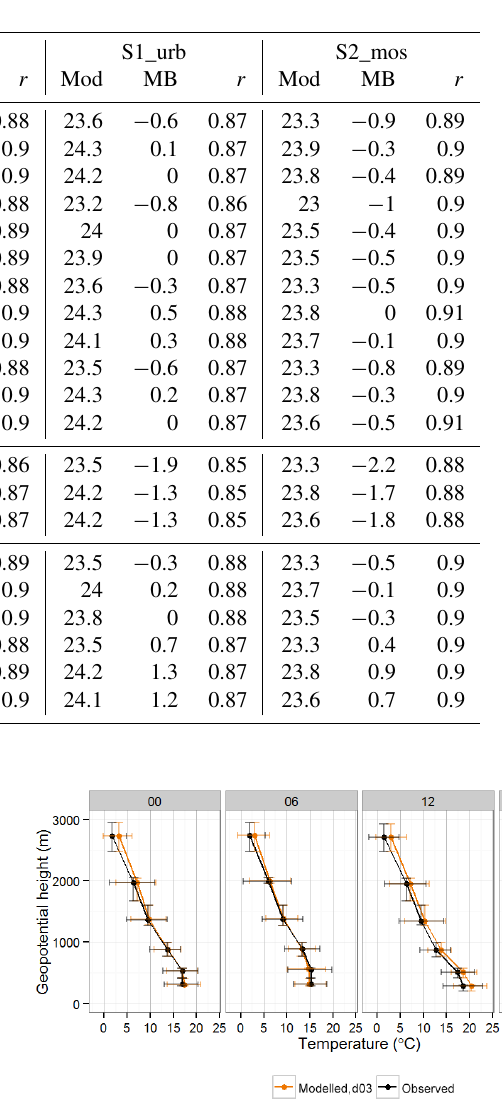
Table 5. Statistics of daily maximum 2m temperature for JJA for stations, where the land use class of the respective grid cell changes with resolution. “LU” refers to the WRF land use class of the grid cell in the respective domain, “Obs” refers to the JJA observed mean, “Mod” refers to the JJA modelled mean for the respective grid cell. MB is the mean bias for JJA and r is the correlation of hourly values. Obs, Mod and MB are in ◦ C. The statistics are shown for the results from the model domains of 15km (d01), 3km (d02) and 1km (d03) horizontal resolution.